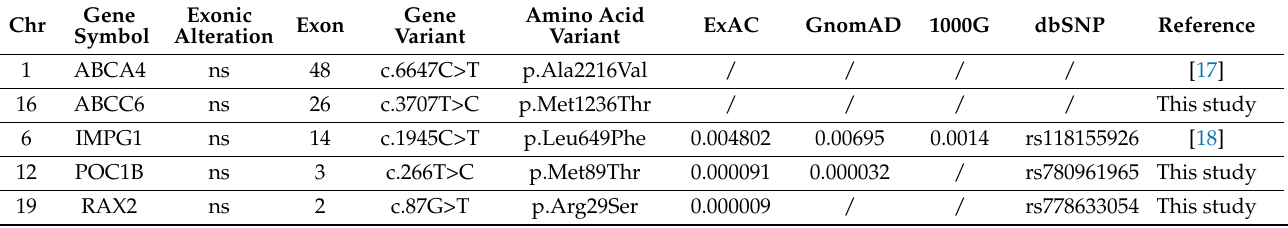
Table 1. List of rare sequence variants in IRD genes found in patient in heterozygous